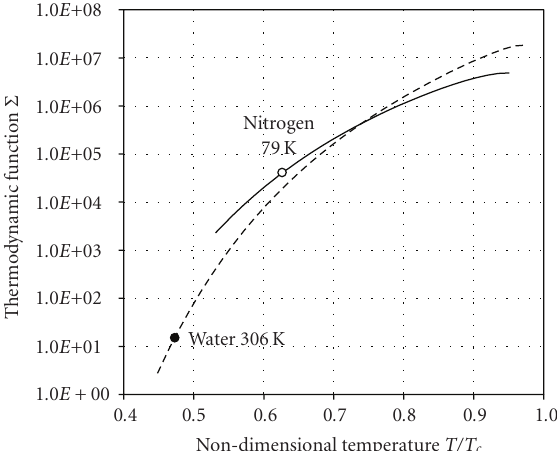
Figure 7: Comparison of the thermodynamic function Σ ( T ) of nitrogen and